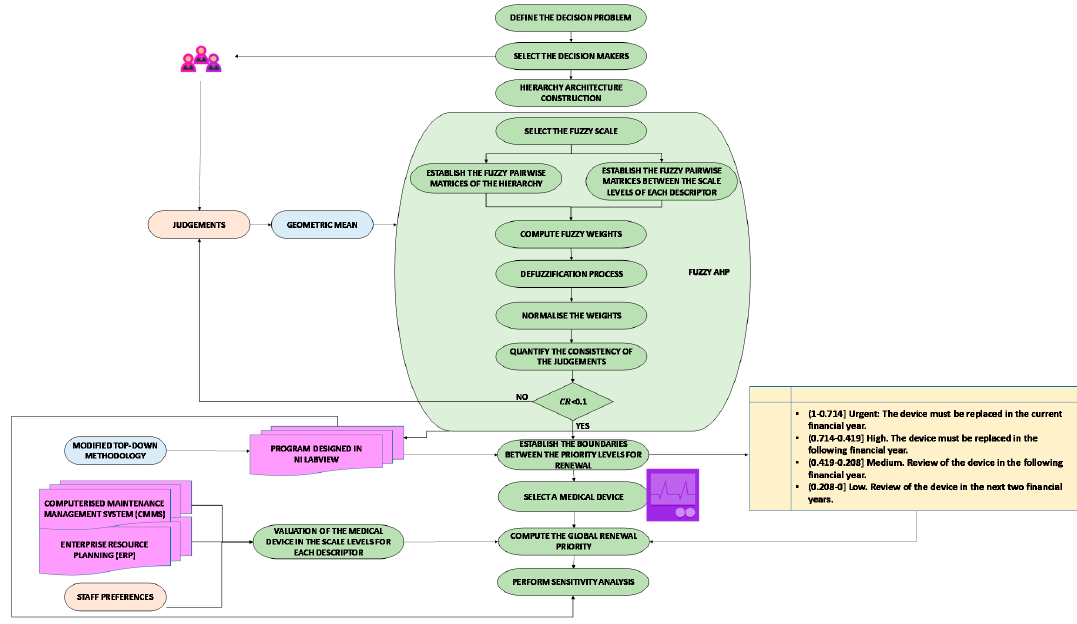
Figure 1. Flowchart of the study.